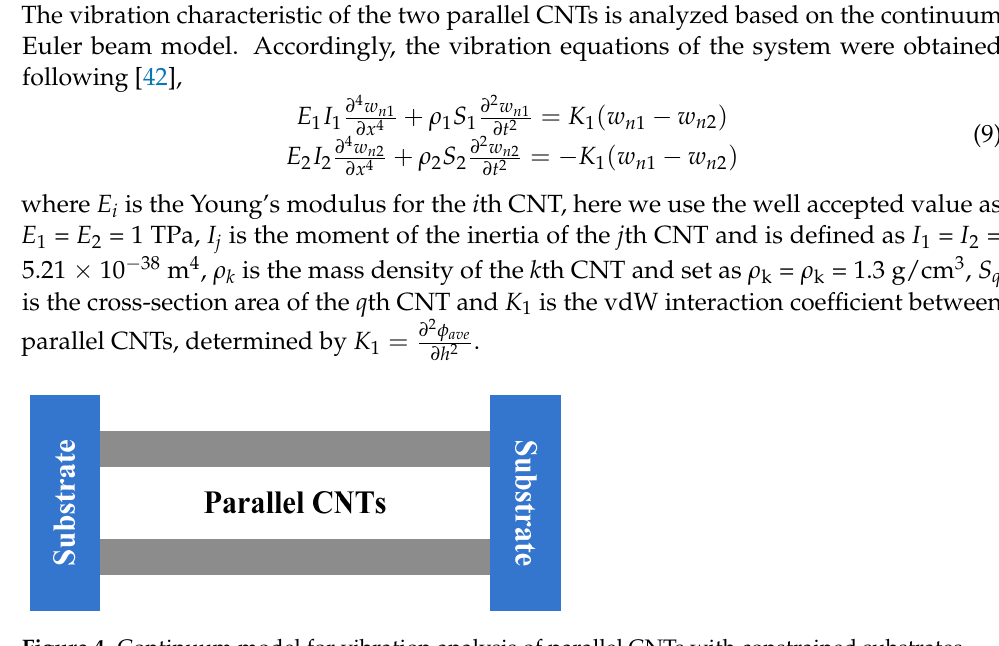
Figure 4. Continuum model for vibration analysis of parallel CNTs with constrained substrates.